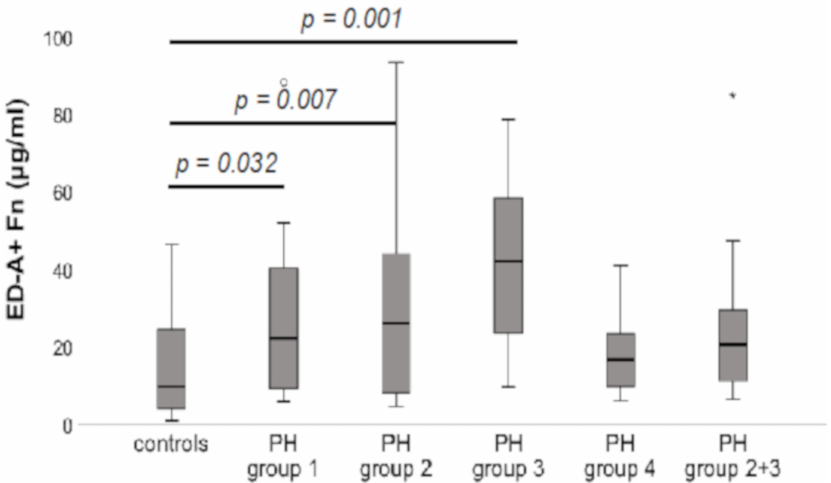
Figure 2. Subgroup analysis of the ED-A + Fn serum levels in patients with pulmonary hypertension (PH) compared to healthy controls. Subgroup analyses were performed according to the different clinical PH groups 1–4 according to current guidelines. The box plots indicate the median (line inside the box), 25th and 75th percentile (lower and upper boundary of the box), 10th and 90th percentile (whiskers outside the box), as well as outlier values (dots). PH = pulmonary hypertension, Fn =